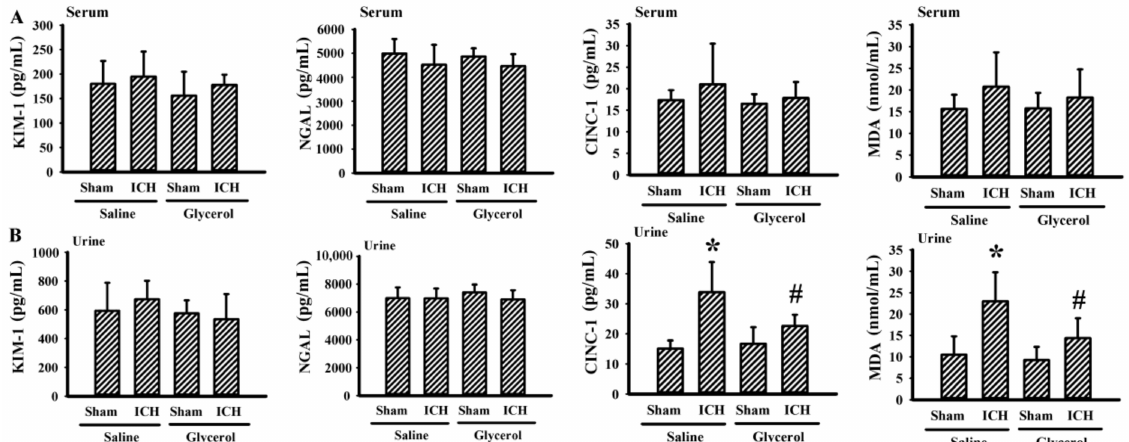
Figure 5. Glycerol alleviated urine biomarkers in hemorrhagic stroke rats. ICH and sham rats were intraperitoneally injected with saline or glycerol and housed for an additional 24 h. Serum ( A ) and urine ( B ) samples were subjected to ELISA for the measurement of KIM-1, NGAL, and CINC-1 as well as to TBARS assay for the measurement of MDA. * p < 0.05 vs. sham/saline and # p < 0.05 vs. ICH/saline, n =